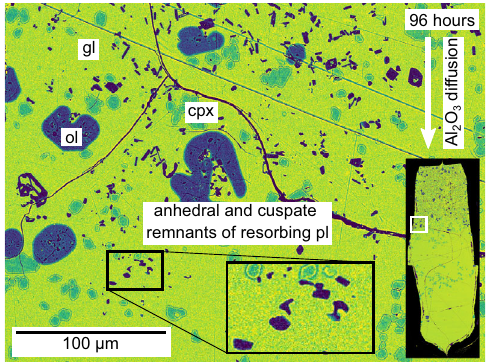
Fig. 9 False-colour backscattered electron (BSE) image showing plagioclase resorption in the products of the 96-h magma – magma reaction experiment. Many plagioclase (pl, purple) crystals close to plagioclase resorption fronts show resorbed textures, and the last remnants of resorbing plagioclase crystals are especially anhedral and cuspate (see inset). Glass (gl) is shown in yellow to green colours. Some olivine (ol, blue) crystals close to plagioclase resorption fronts are anhedral and embayed, whereas clinopyroxene (cpx, blue-green) crystals retain euhedral to subhedral erupted crystal cargoes and carrier liquids are often derived from chemically distinct primary melt distributions that have evolved along different liquid lines of descent 22,65,66 . It is thus feasible that mush-derived crystals will have never been in equilibrium with melts parental to their eventual carrier liquids. A key consequence of this is that mush disaggregation may be triggered by differ- ences in magma composition as well as by differences in magma temperature.